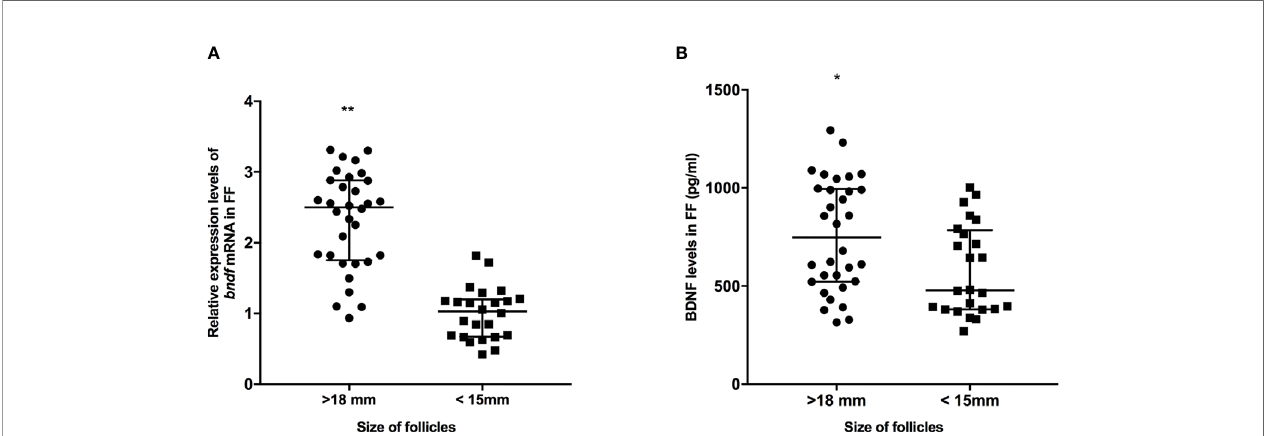
FIGURE 1 | The expression levels of bdnf (A) and BDNF proteins (B) in FF from mature (>18 mm) and immature (<15 mm) follicles. *P < 0.05; **P < 0.01. Data are presented as the mean ± standard deviation. Student ’ s t-test or Mann-Whitney tests were performed to determine the differences between two groups based on the normality of the distribution of